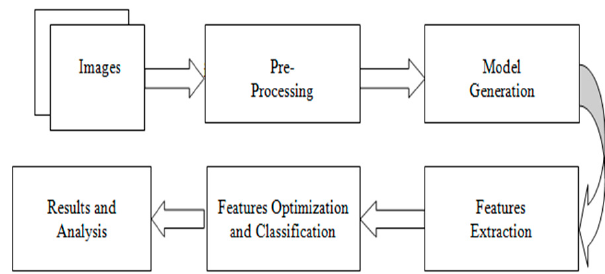
Figure 1. Generic automated classification flow diagram.